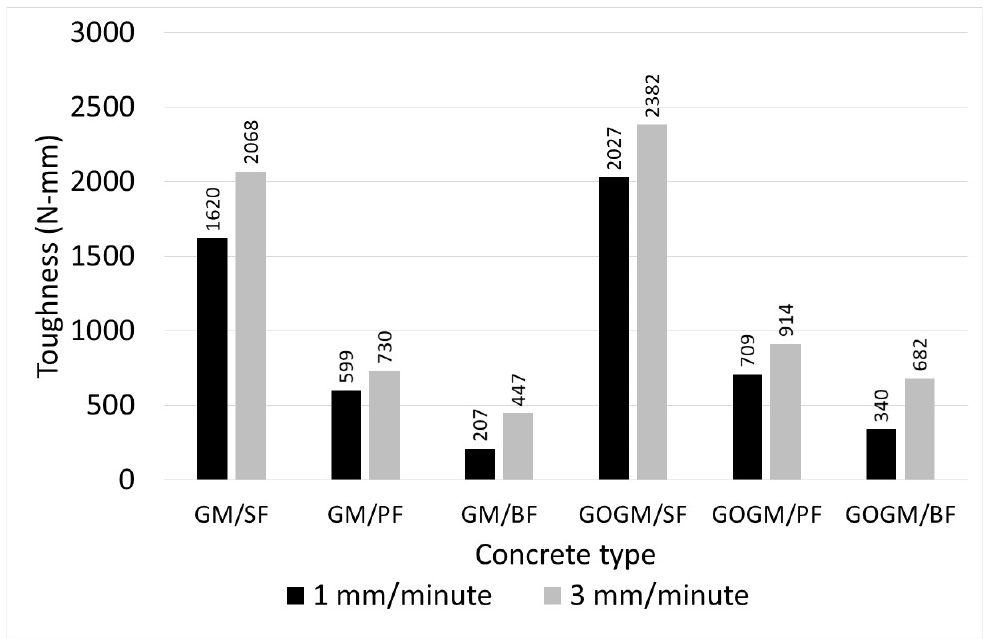
Figure 8. Pullout energy or toughness. For bond-slip toughness, the SF provided the highest toughness among the fibers (around 1620–2382 N-mm) due to its high strength and ductility. The PF, which has relatively lower strength, produced lesser toughness (around 599–914 N-mm). Even though BF has higher tensile strength than PF, its brittleness and twisted bundle alignment caused the fracture failure to occur prior to slipping. This cut short its bond-slip responses and prevented a post-peak response from occurring. Thus, BF yielded the lowest toughness (around 207–682 N-mm). Regarding the effect of GO, the toughness was found to increase at different angles depending on the fiber type. Comparing GM and GOGM, the percentage difference in peak load at two different rates of loading is shown in Figure 9. For GM, the increase in peak load was found at around 8, 9.6, and 4.8% for GM/SF, GM/PF, and GM/BF, respectively. For GOGM, the increase in peak load was observed at around 12.9, 12.9, and 11.2% for GOGM/SF, GOGM/PF, and GOGM/BF, respectively. This indicated that the GOGM is more sensitive to the rate of loading than GO. This perhaps has to do with the increase in matrix strength, which provided more resistance to the pull